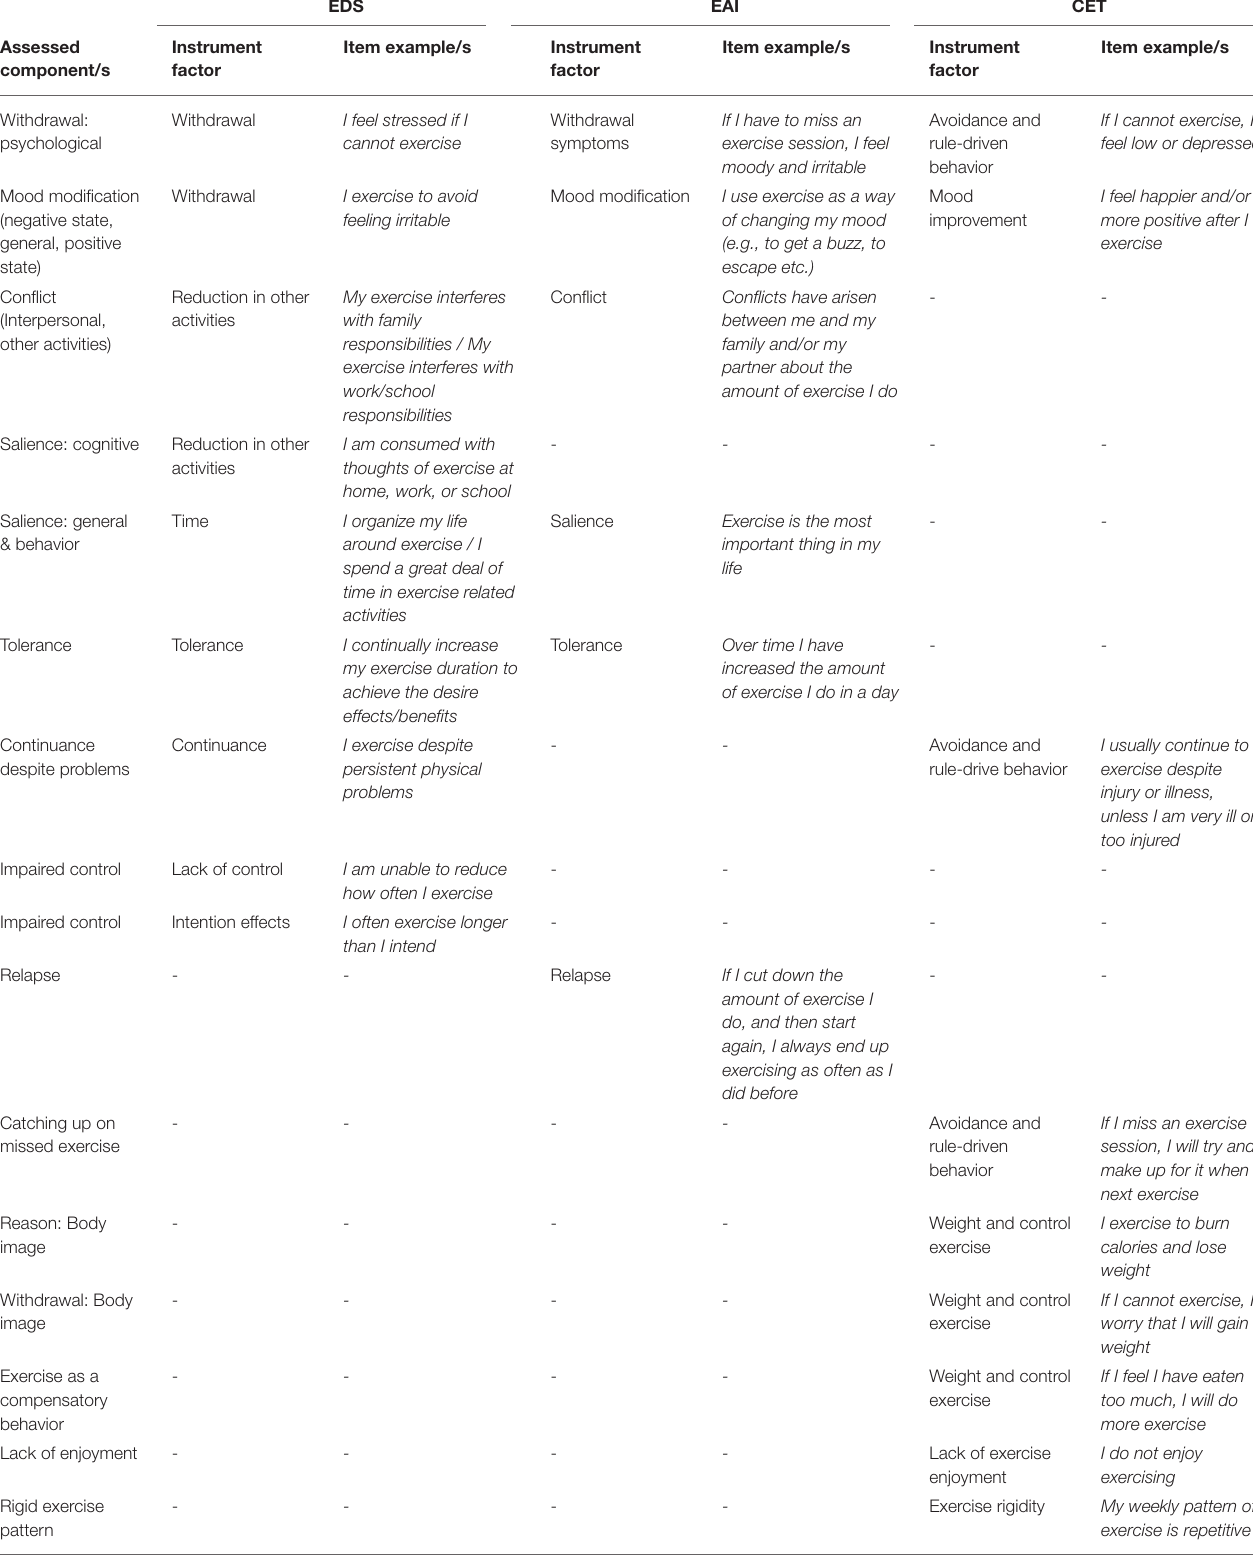
TABLE 1 | Comparison of components assessed by the EDS, EAI and CET.